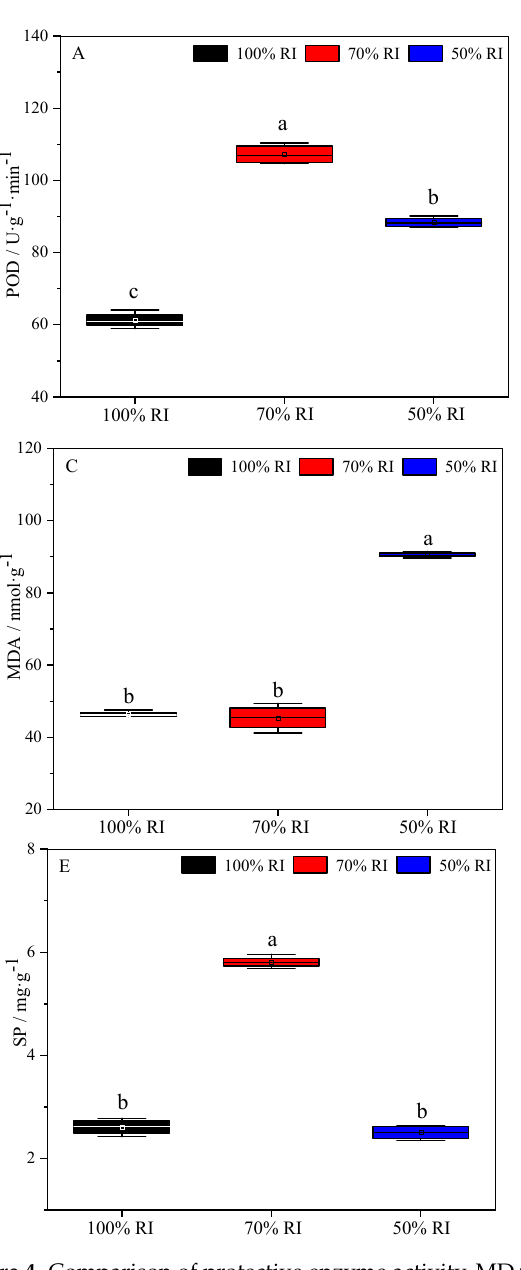
Figure 4. Comparison of protective enzyme activity, MDA content, and osmotic regulating substances in seedlings under different light treatments (means ± SDs), n = 6. Abbreviations: RI, relative irradiance. The letters denote: ( A ) POD, peroxidase (U·g − 1 ·min − 1 ); ( B ) SOD, superoxide dismutase (U·g − 1 ); ( C ) MDA, malondialdehyde (nmol·g − 1 ); ( D ) SS, soluble sugar (%); ( E ) SP, soluble protein (mg·g − 1 ); ( F ) PRO, proline (µg·g − 1 ). Significant differences are indicated by different letters (a,b and c): p < 0.05.